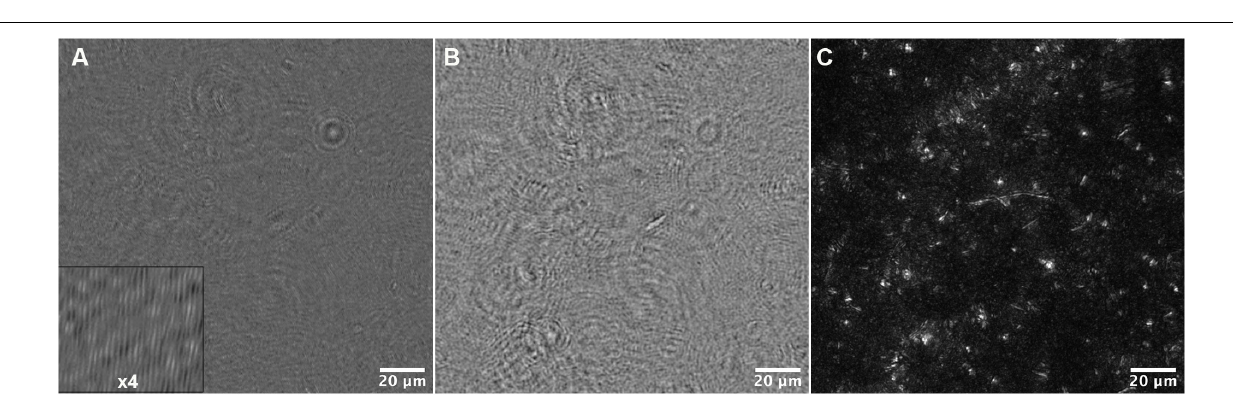
FIGURE 5 | Data reconstruction and processing for tracking. (A) A portion of the field of view of a median-subtracted hologram from the 34 ◦ C dataset. The inset shows part of the image magnified 4x to show the fringes. (B) Amplitude reconstruction of the same field of view in (A) at +50 µ m. (C) Maximum Z projection of the same field of view, representing reconstructions from − 200 to +200 µ m in steps of 10 µ